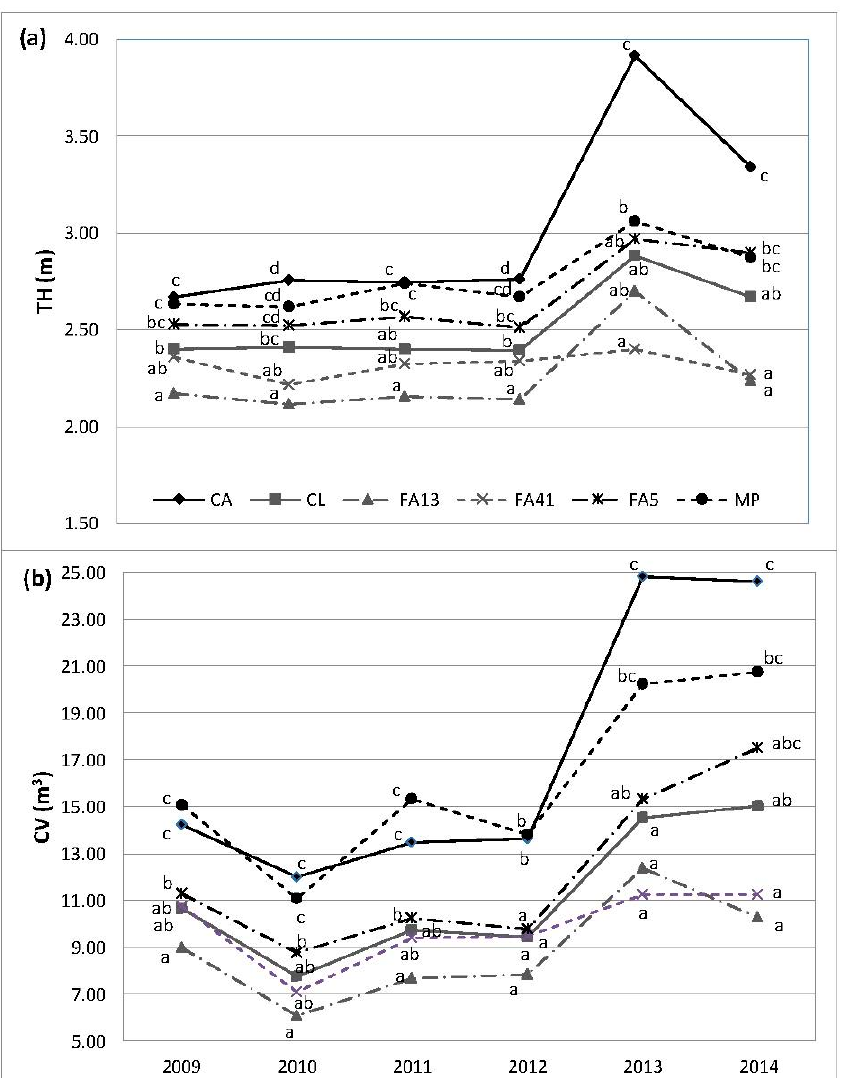
Figure 2. Effect of rootstocks on height (TH; a ) and canopy volume (CV; b ) in the ‘Lane Late’ navel orange tree over six growing seasons: 2008/2009–2013/2104. Mean values in the same growing season with different letters denote significant differences among rootstocks, based on Tukey’s test ( p < 0.05). CA: Carrizo citrange; CL: ‘Cleopatra’ mandarin; FA13: Forner-Alcaide no.13; FA41: Forner-Alcaide no.41; FA5: Forner-Alcaide no.5; MP: C. macrophylla Wester.